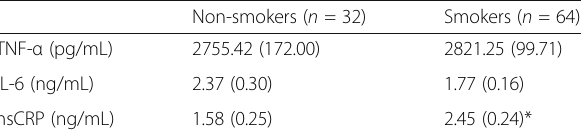
Table 2 Pre-intervention inflammatory markers between non- smokers and smokers groups